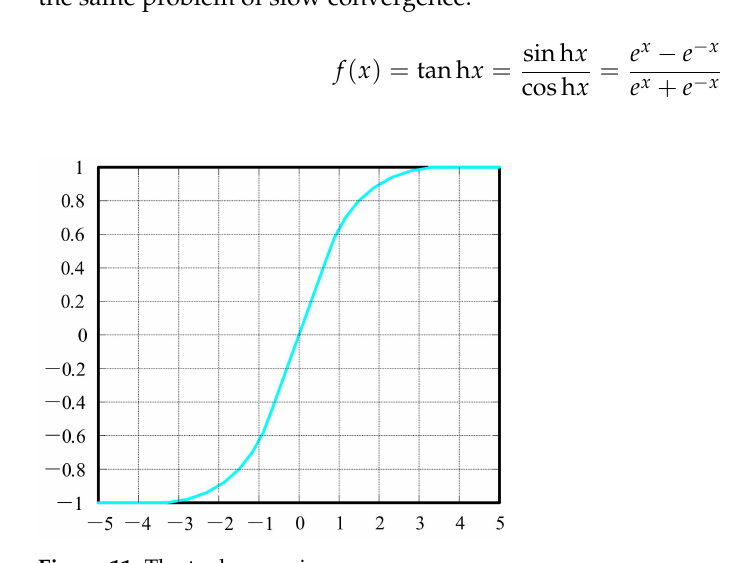
Figure 11. The tanh curve